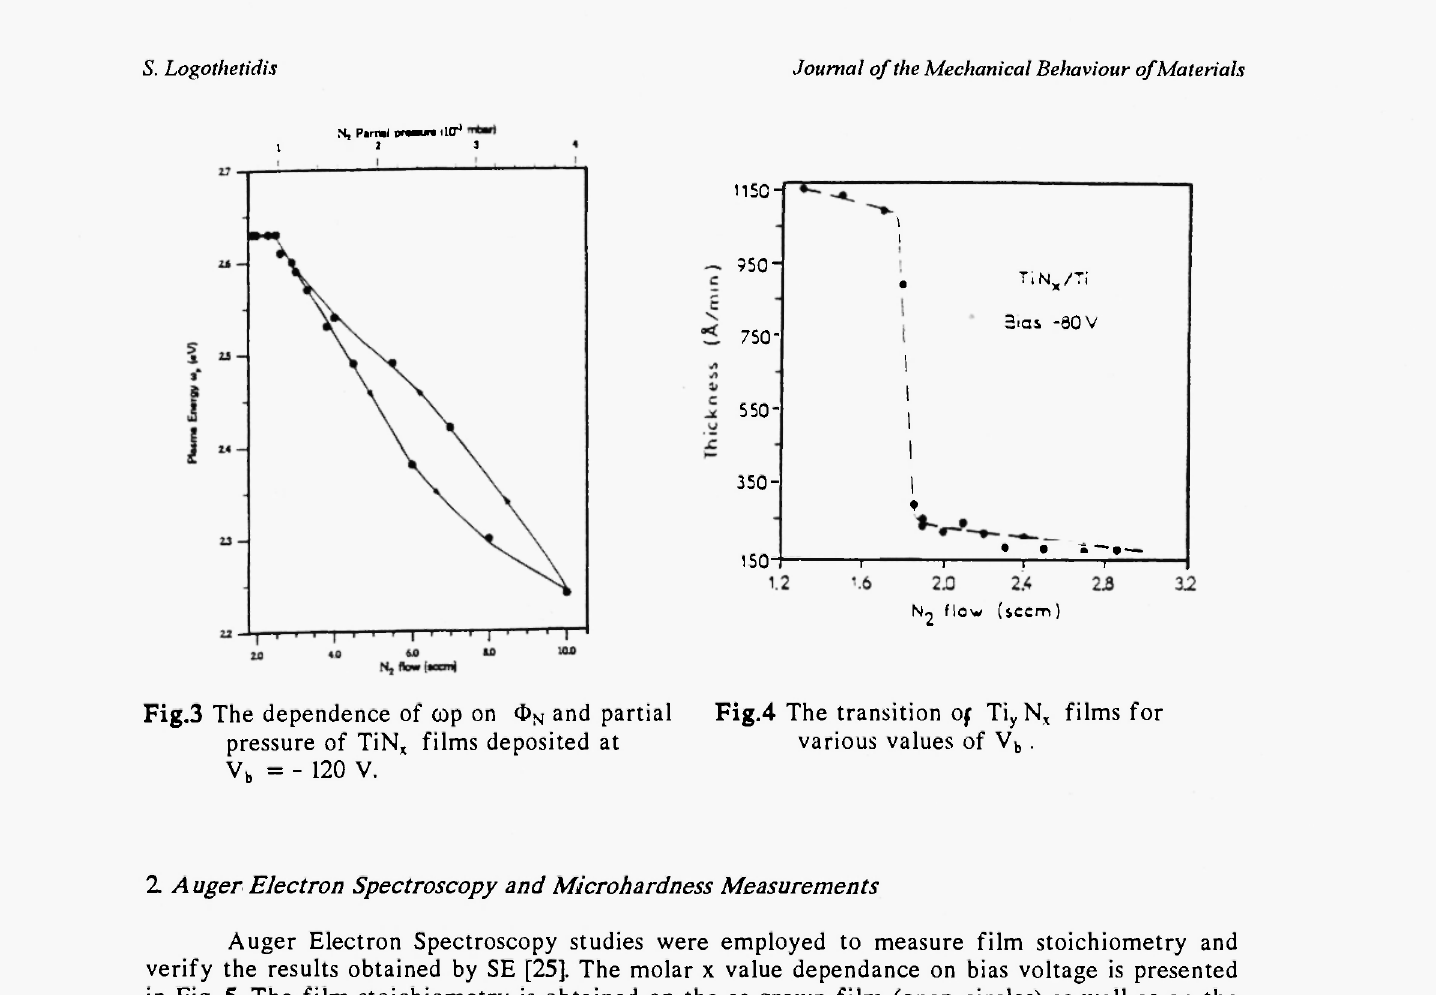
Fig.3 The dependence of ωρ on Φ Ν and partial pressure of TiN x films deposited at V b = - 120 V.